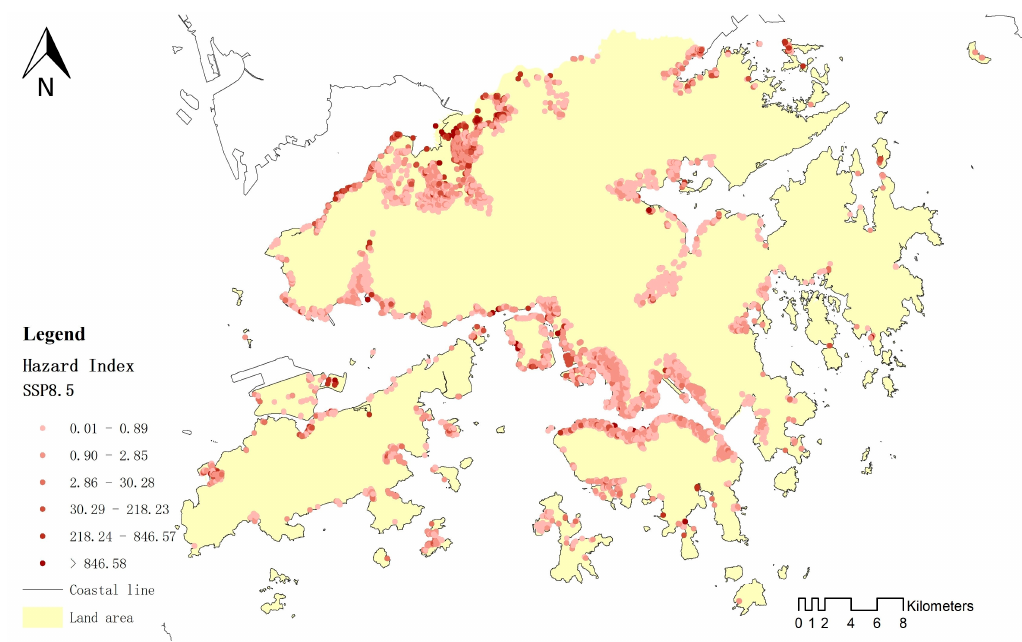
Figure 8. Map of hazard index for buildings (SSP8.5).